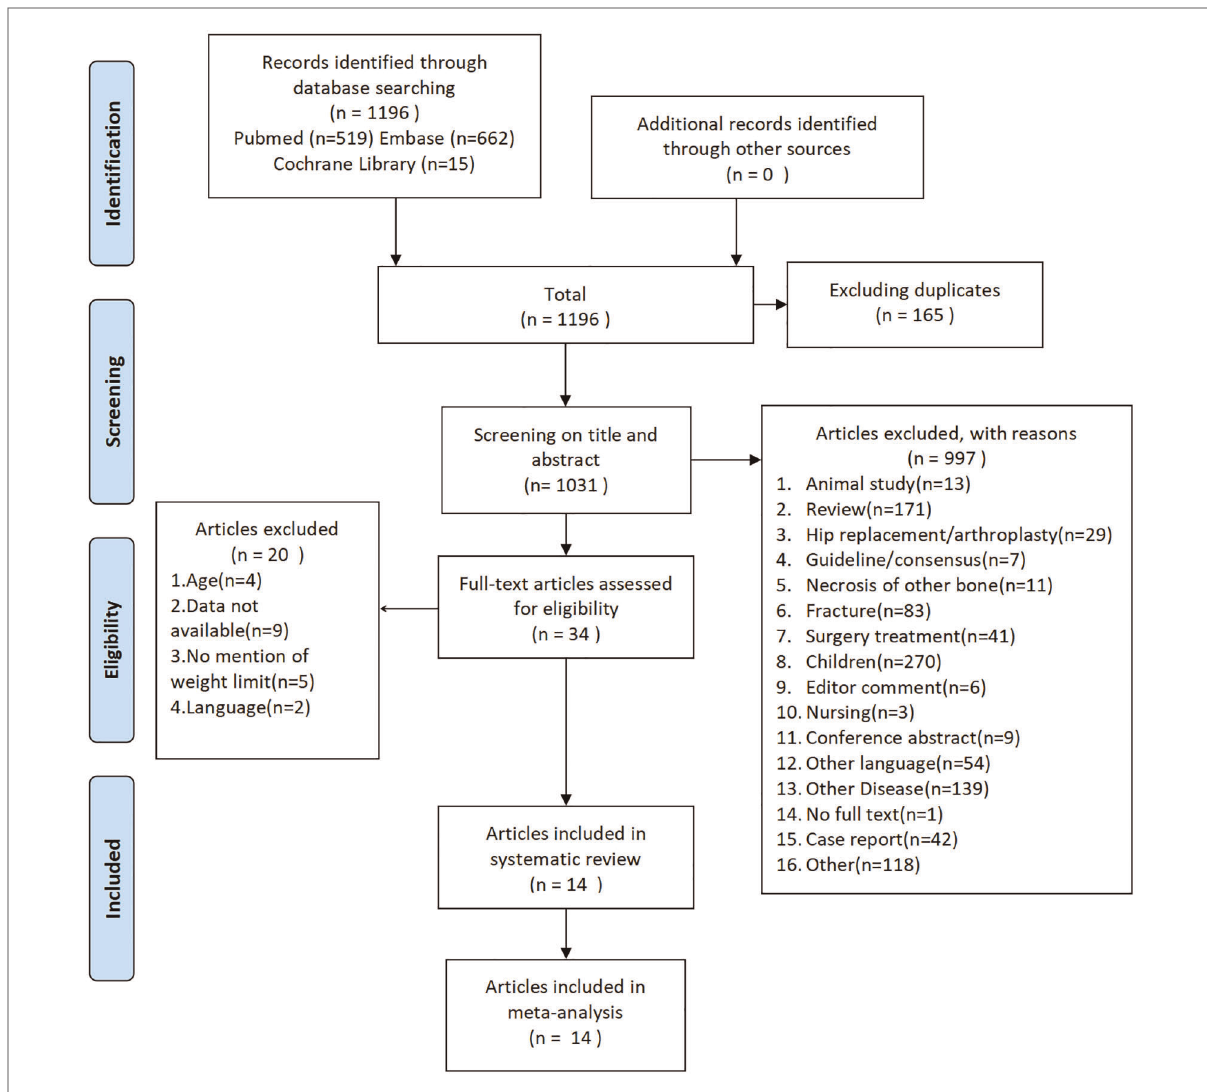
FIGURE 1 Flow diagram showing the study selection